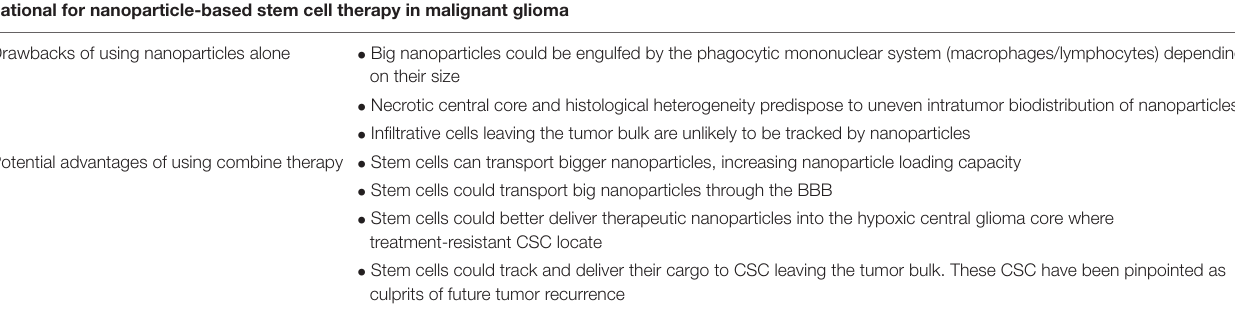
TABLE 4 | Rational for a combinatorial approach using nanoparticles and stem cell therapy in malignant glioma. Rational for nanoparticle-based stem cell therapy in malignant glioma Drawbacks of using nanoparticles